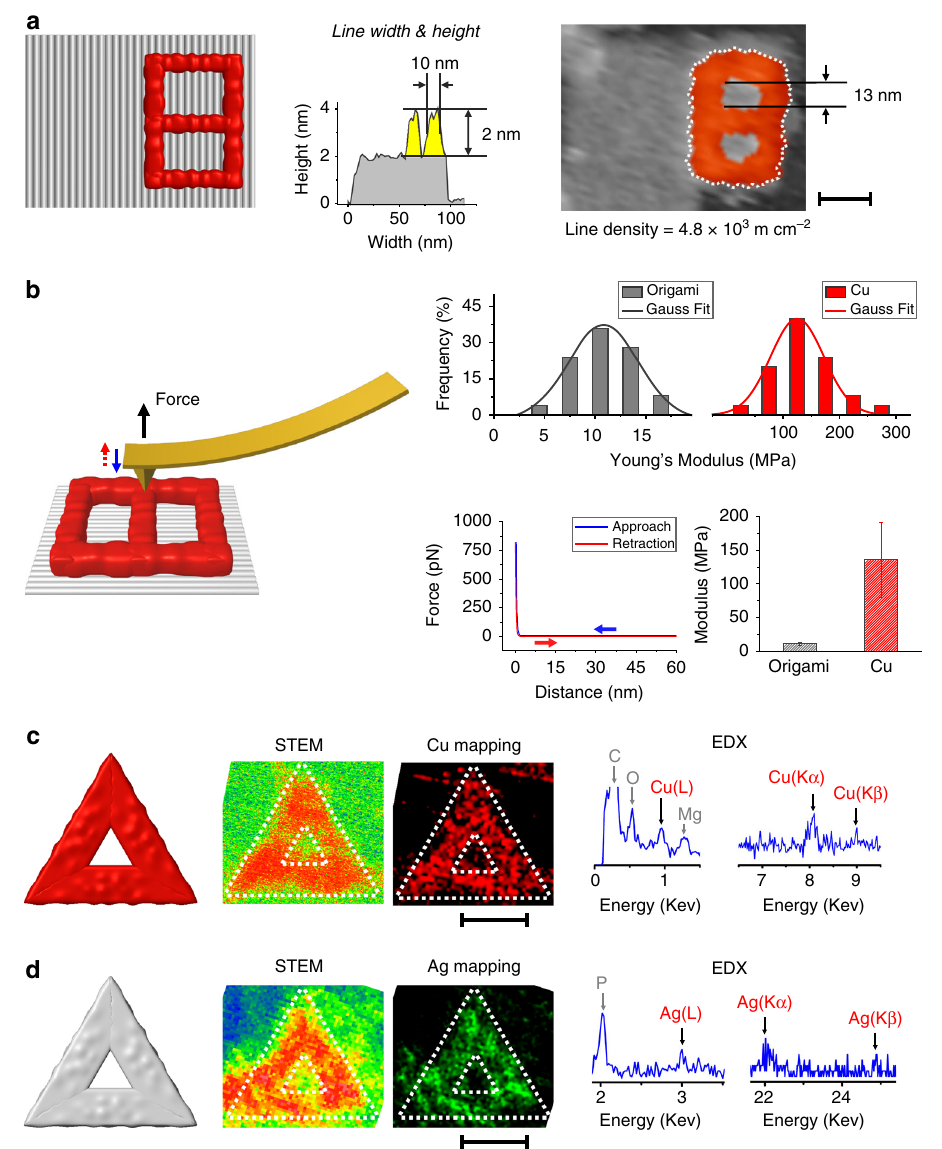
Fig. 3 Characterization of DCIMP. a A small-sized digit 8 pattern enabling the measurement of line width and density. Scale bar: 25 nm. b Force-distance (FD) curve-based AFM (FD-based AFM) characterization of nanomechanical properties of metalized patterns. The error bars are the standard deviation for N = 25 and 25 samples with the origami and the metalized patterns, respectively. c Cu plating on a whole triangular origami with STEM and elemental mapping characterization. Scale bar: 50 nm. d Ag plating on a whole triangular origami with STEM and elemental mapping characterization. Scale bar: 50 nm.